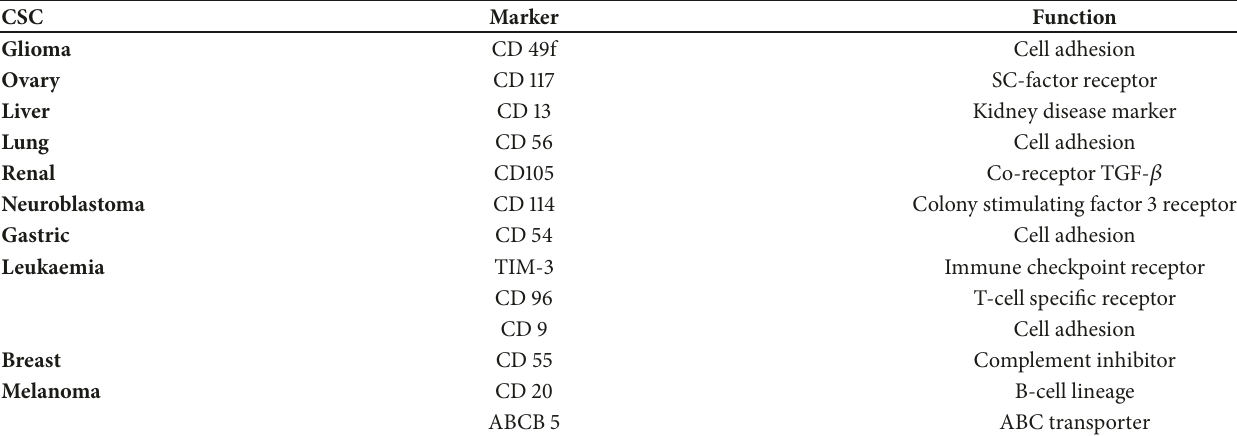
Table 2: Specific CSC markers and function [adapted from